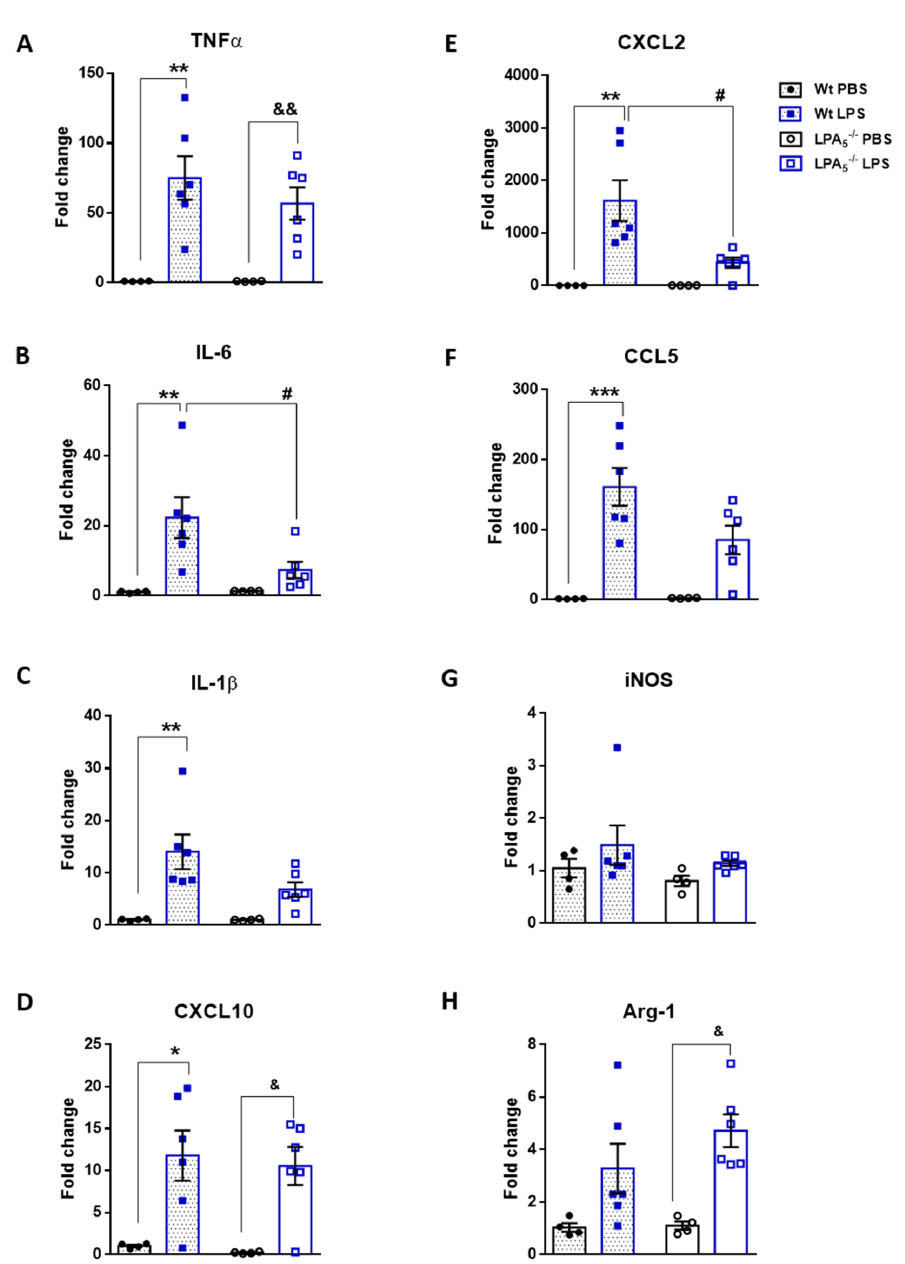
Figure 2. LPA 5 deletion attenuates expression of pro-inflammatory genes in mouse brain. Wt and LPA 5-/- mice were injected i.p. with PBS ( n = 4) or LPS (5 mg/kg; n = 6). After 24 h, the animals were sacrificed and perfused. Brains were processed for RNA isolation and gene expression of ( A ) TNF α , ( B ) IL-6, ( C ) IL-1 β , ( D ) CXCL10, ( E ) CXCL2, ( F ) CCL5, ( G ) iNOS, and ( H ) Arg-1 was evaluated by qPCR. Hypoxanthine-guanine phosphoribosyltransferase (HPRT) was used as housekeeping gene. Expression was calculated using the 2 −ΔΔ Ct method. Results are presented as mean values ± SEM, * p < 0.05, ** p < 0.01, *** p < 0.001 compared to wt PBS control; & p < 0.05, && p < 0.01 compared to LPA 5-/- PBS control; # p < 0.05 compared to LPS-treated wt mice; two-way ANOVA with Bonferroni correction).